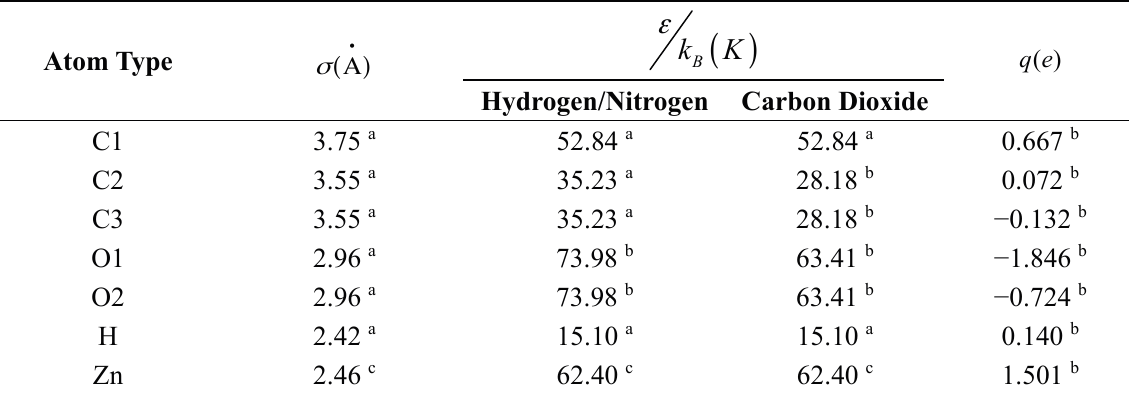
Figure 3. Model clusters for different atoms. Table 2. New LJ parameters for MOF-5